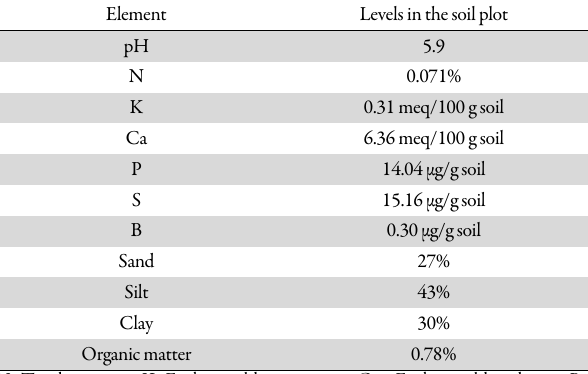
Table 1. Composition of soil elements of the experimental field Element Levels in the soil plot pH